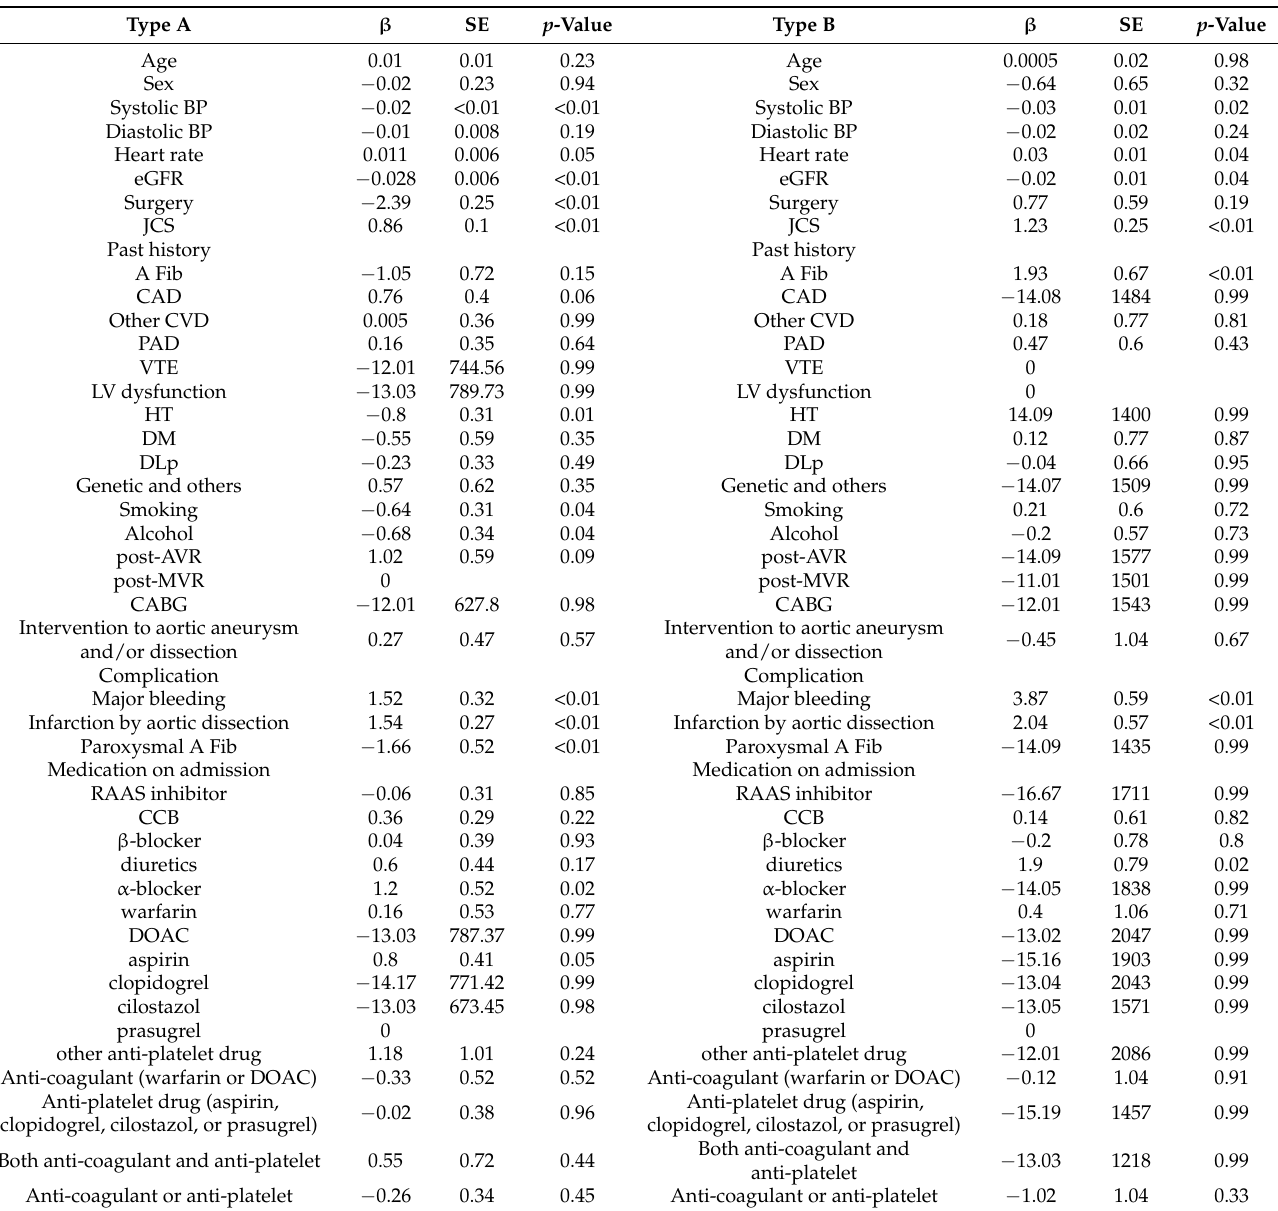
(Table 4). According to this analysis, the use of anti-thrombotic drugs (warfarin, DOAC, aspirin, clopidogrel) was not a predictor of all cause death (Table 4). Table 4. Cox proportional hazard model for all-cause mortality in TRANSFERRED acute aortic dissection